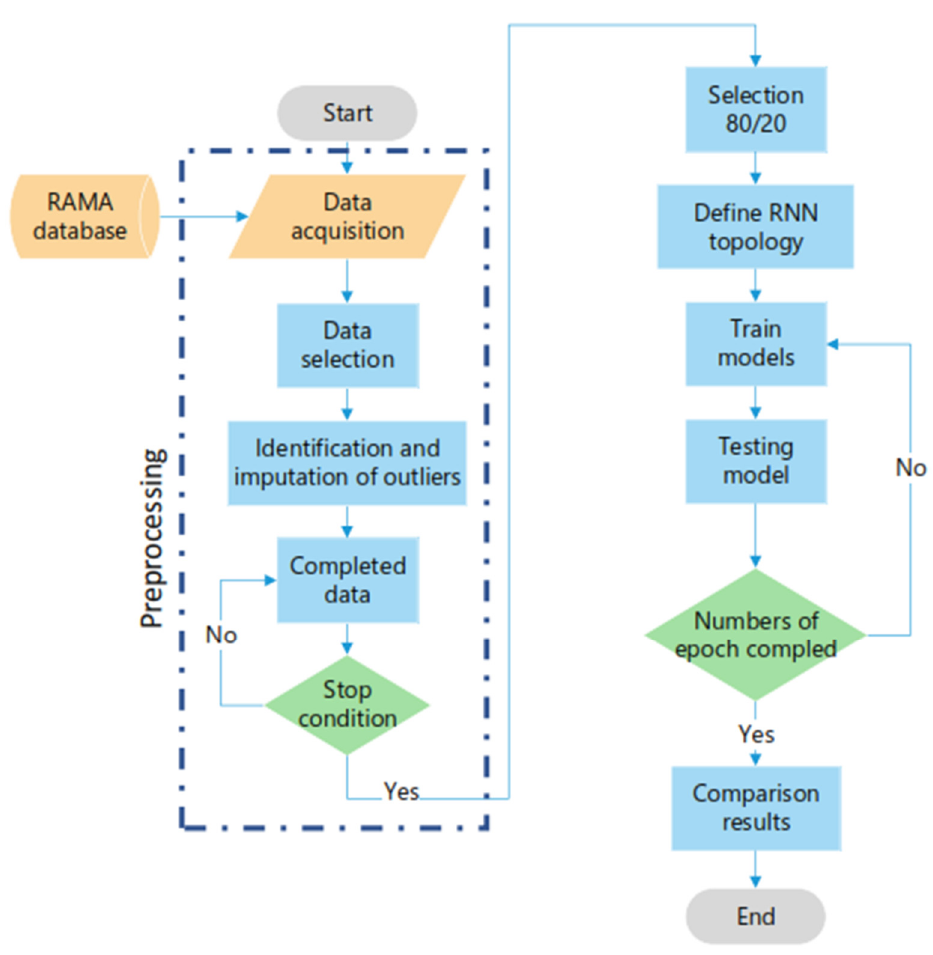
Figure 6. Implemented methodology.